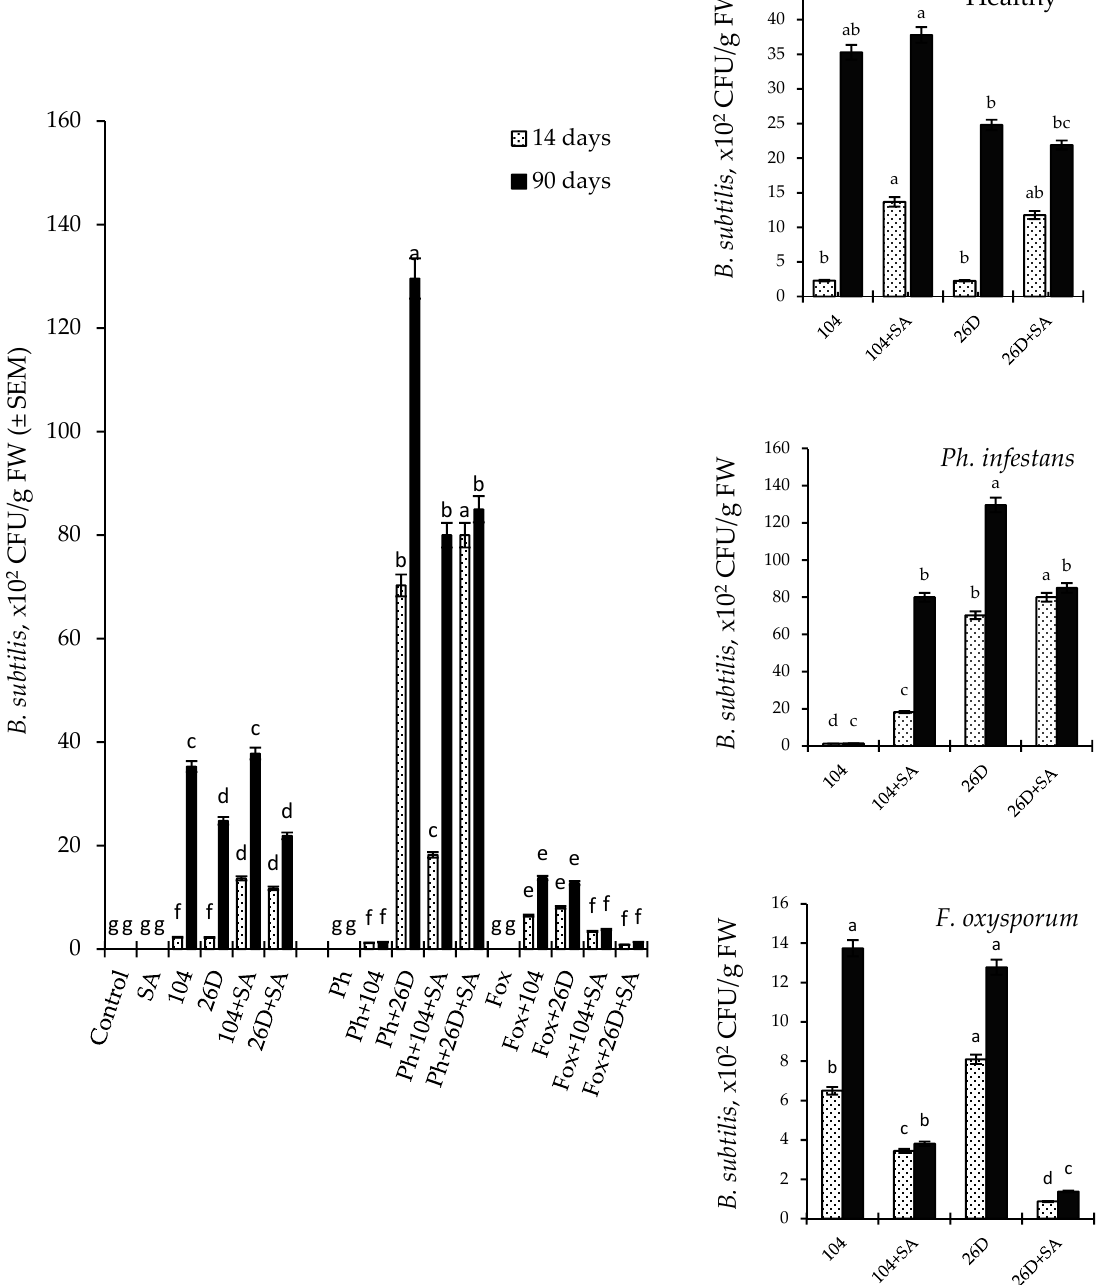
Figure 5. Change in the titer of endophytic B. subtilis bacteria (strain 10-4 and 26D) in stored healthy and infected with Ph. infestans (Ph) and F. oxysporum (Fox) potato tubers treated immediately before storage with B. subtilis 10-4 (104), B. subtilis 26D (26D) and their compositions with SA. The bars are the means of three repetitions ± SEM. Different letters indicate a significant difference between the means at the probability level of p < 0.05.